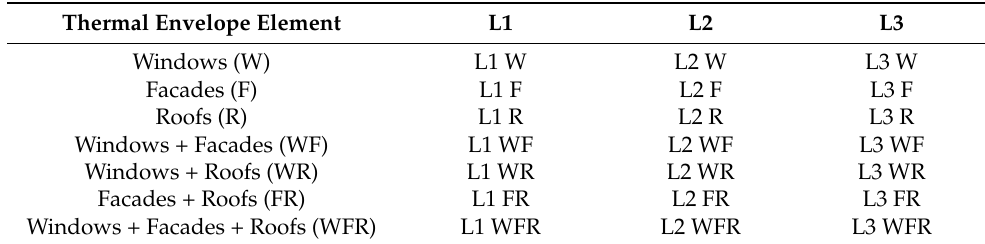
Table 4. Set of measures for thermal envelope according to a combination of energy demand levels and elements in thermal envelope to be